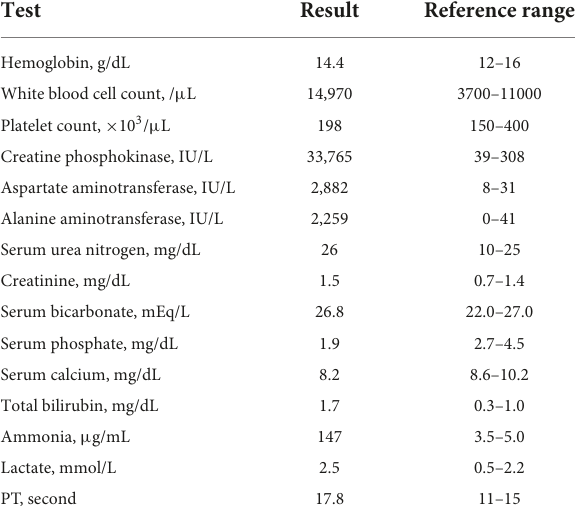
TABLE 1 Laboratory data at emergency